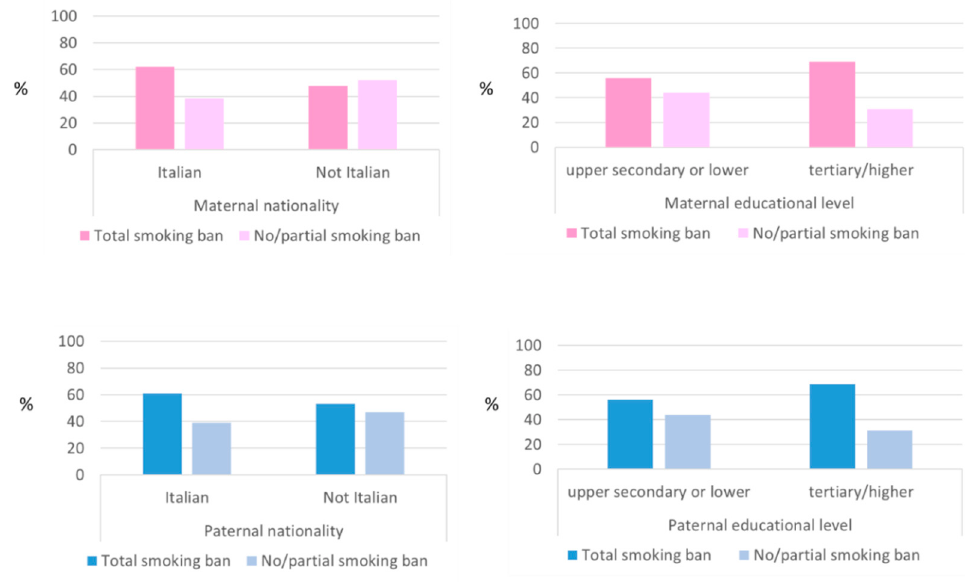
Figure 2. Association between maternal and paternal nationality or educational level and home smoking policies in children exposed to ETS.